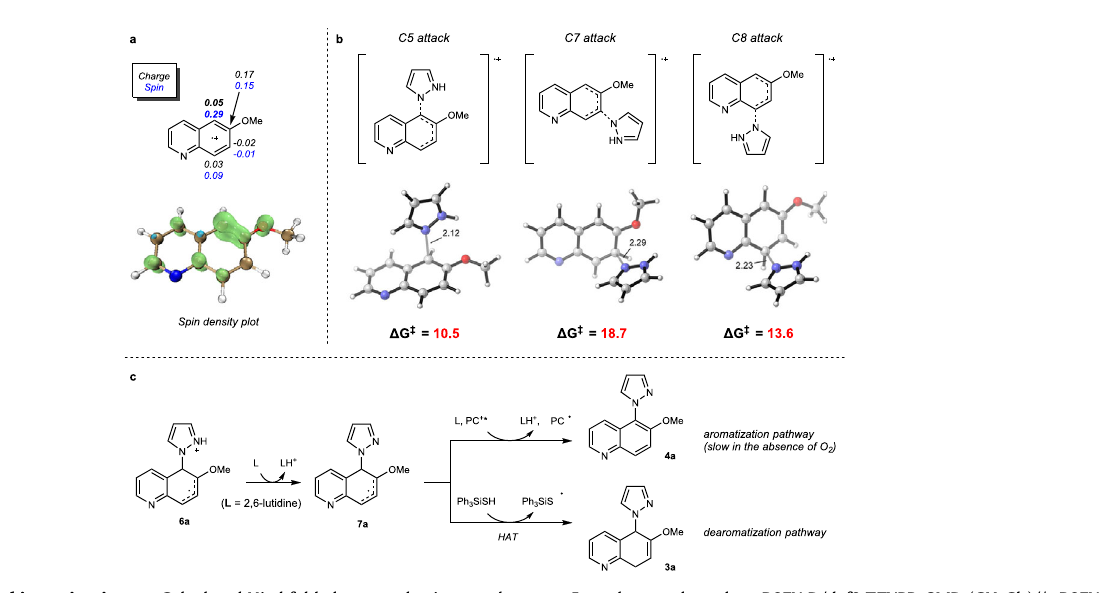
between 5a and pyrazole at the ω B97X-D/def2-TZVPP, SMD (CH 2 Cl 2 )// ω B97X-D/ def2-SVP level of theory. Free energies are in kcal/mol, and interatomic distances are in Å. c Possible fates of radical cation 6a .